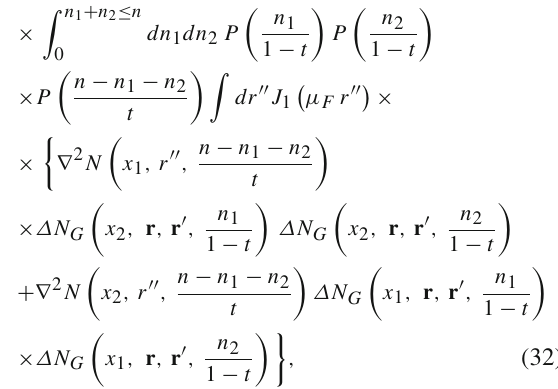
data are from [26,62]. In both plots the dashed curves labeled “Small- n approx.” correspond to evaluation with a dipole amplitude (16). The curves labeled “2-gluon” in both plots correspond to n -dependence of the gluon-gluon fusion mechanism, as explained in the text. In both plots we use the LC Gauss wave function [49] (see Appendix B) for more